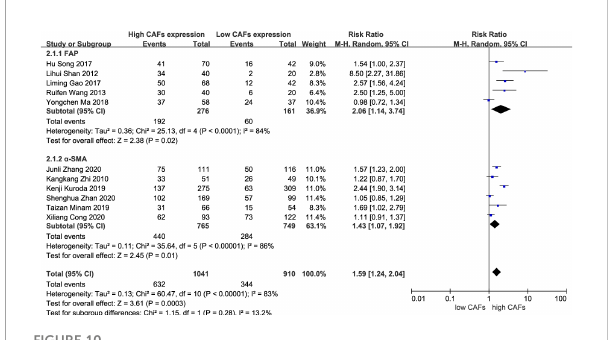
FIGURE 10 Subgroup analysis of high expression of CAFs and stage III – IV gastric cancer. CAF, cancer-associated fi broblast; CI, con fi dence